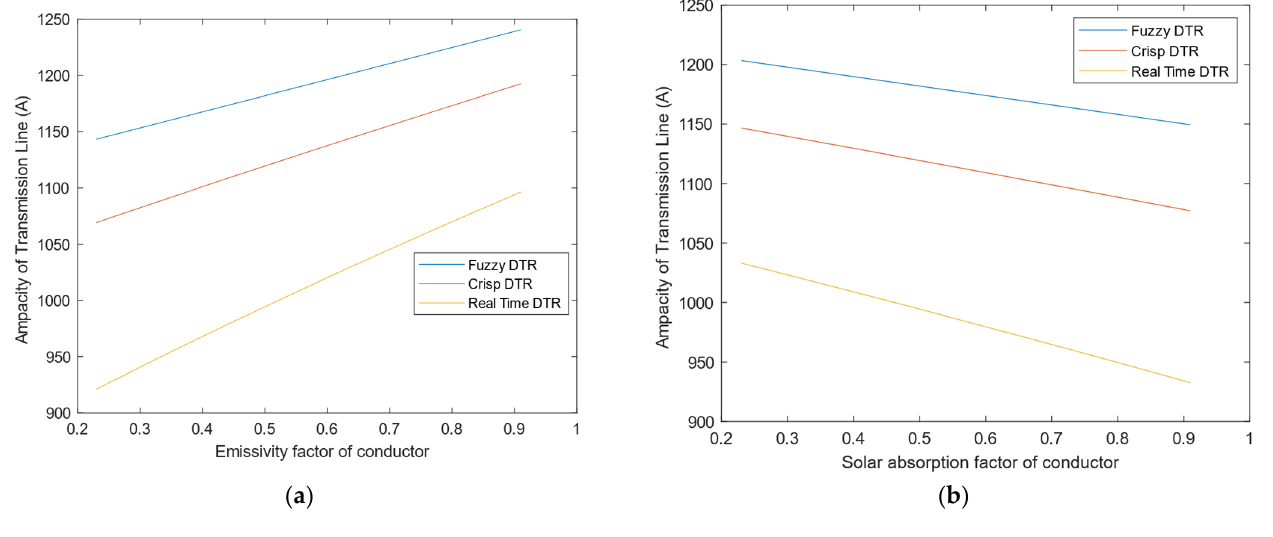
Figure 5. ( a ) Impact of wind emissivity on the transmission line capacity; ( b ) impact of solar absorption on the transmission line capacity.